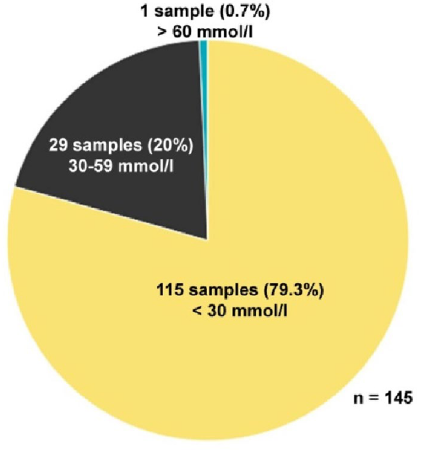
Fig. 3 Measured chloride concentrations in 145 sweat samples taken from patients screened for cystic